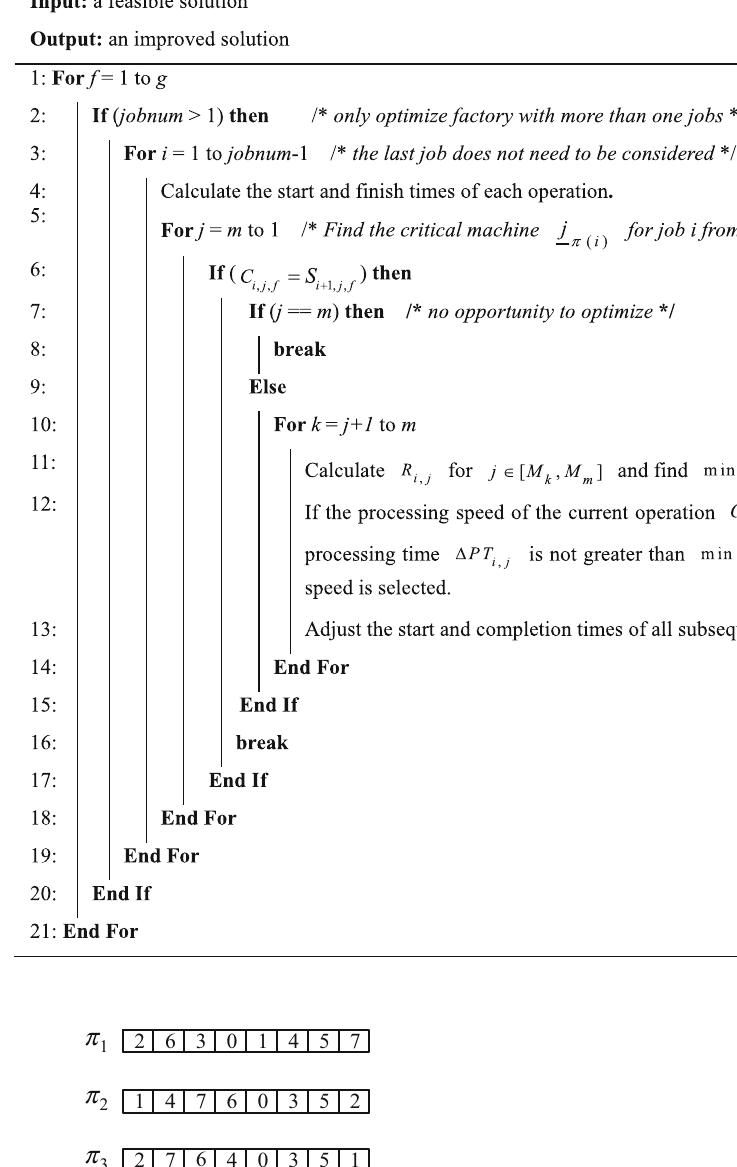
Fig. 5 Non-dominated solution set